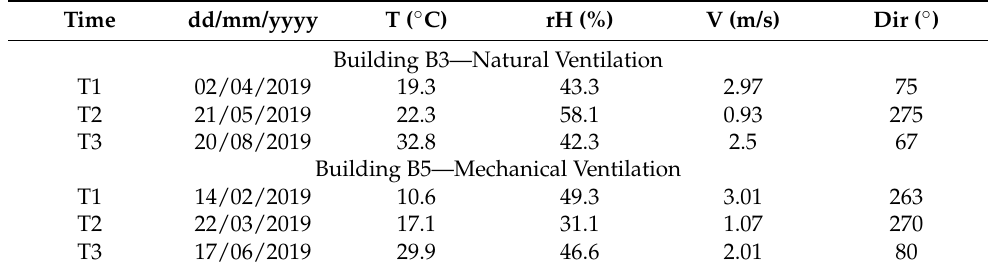
Table 2. Dates and main outdoor characteristics collected for every one of the six scenarios considered in the CFD simulations. Time dd/mm/yyyy T ( ◦ C) rH (%) V (m/s) Dir ( ◦ ) Building B3—Natural Ventilation